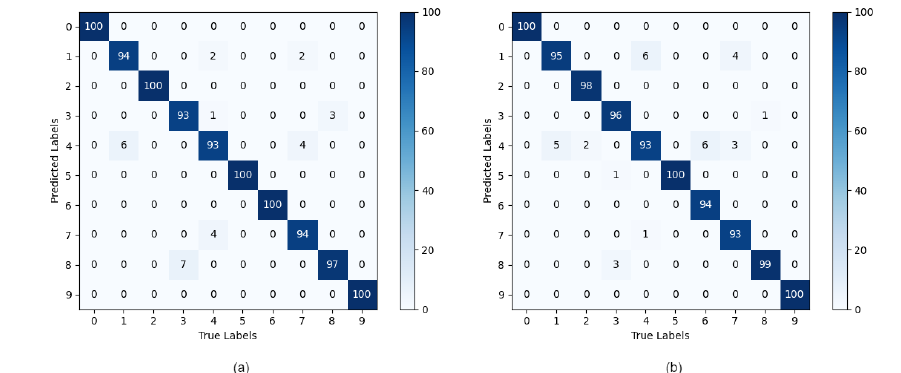
Figure 7. Confusion matrix results for the proposed method at ( a ) 180 samples and ( b ) 120 samples.